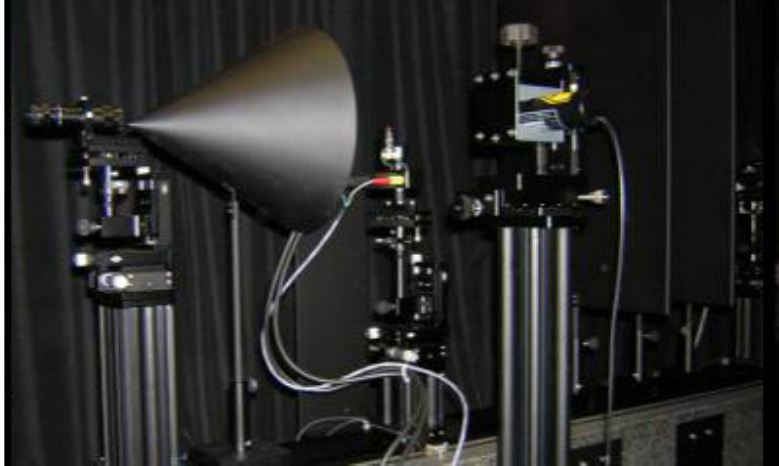
Fig. 1. Photometric bench of the IPQ Photometry